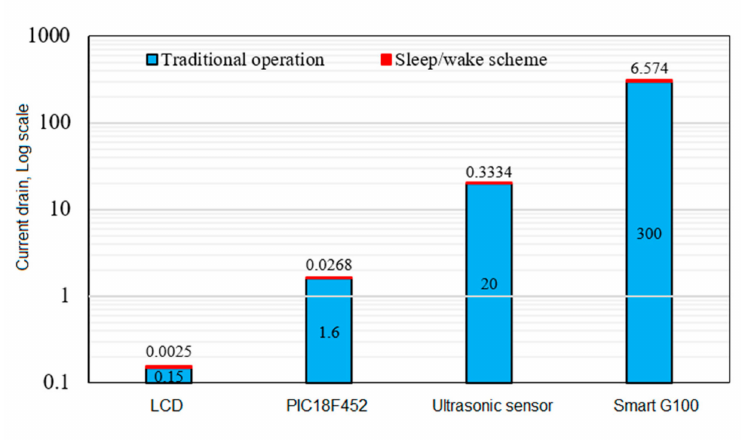
Figure 8. Current drain improvement for each component after applying the sleep / wake scheme.